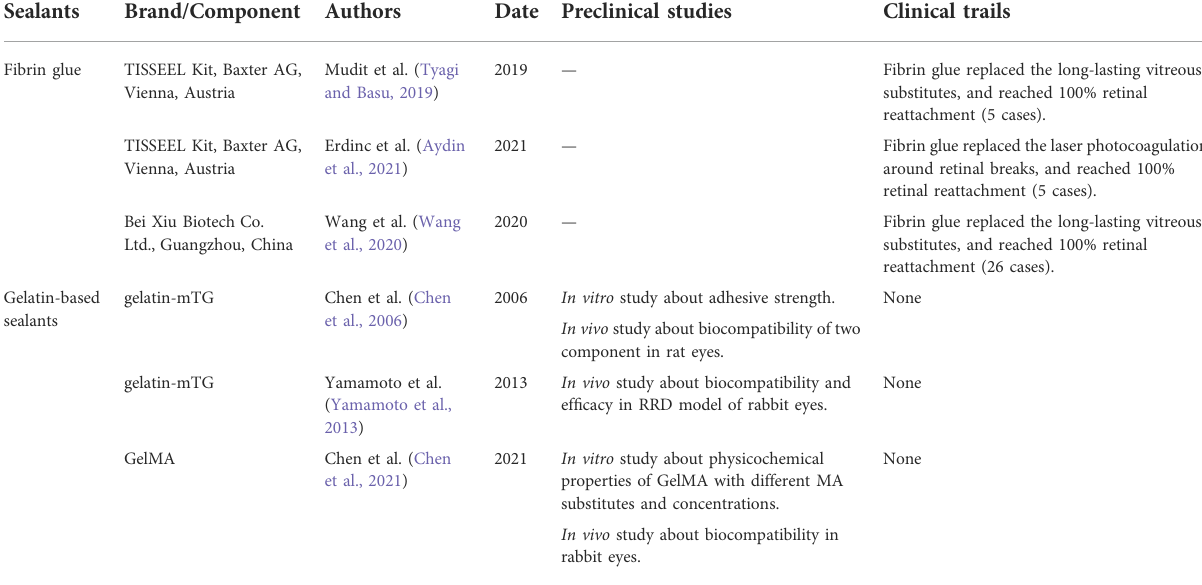
TABLE 2 The summaries of studies about sealants based on proteins as retinal patches for the treatment of RRD. Sealants